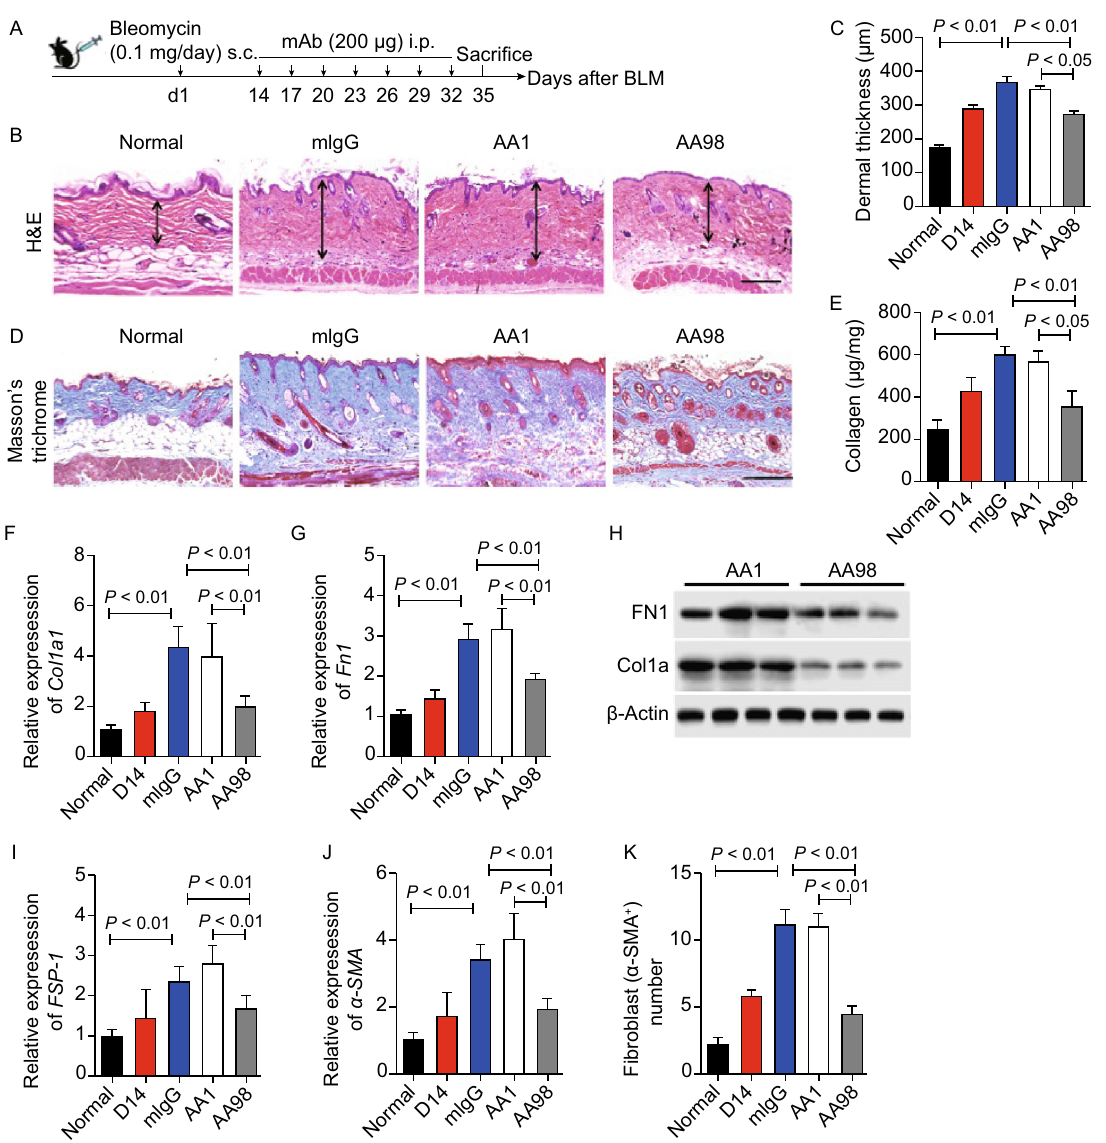
Figure 2. Therapeutic CD146-blocking with AA98 attenuates BLM-induced skin fi brosis . (A) Schematic diagram of CD146- targeting therapy using anti-CD146 AA1 or AA98 in BLM-induced skin fi brosis. (B) Mice were treated with AA1 or AA98 during BLM induction for 21 days. Lesion tissues were sectioned and stained, and dermal thickness was measured using Image J. Representative images are shown (scale bar, 100 μ m). (C) Quanti fi cation of dermal thickness in each group ( ≥ 6 sections per mouse, 10 mice per group). (D and E) Skin sections in each group were stained with Masson ’ s trichrome (D) (scale bar, 100 μ m), and collagen content (E) was measured ( n = 10 per group). (F – H) RT-PCR analysis of Col1a1 (F) and Fn1 (G) mRNA expression ( n = 10 per group) and Western blot analysis of Col1a1 and Fn1 protein expression (H) in fi brotic skin tissues ( n = 3 per group). (I and J) RT- PCR analysis of FSP-1 (I) and α -SMA (J) mRNA expression in fi brotic skin tissues ( n = 10 per group). (K) Quanti fi cation of α -SMA + fi broblasts in skin tissues ( n = 10 per group). Signi fi cant differences were determined by two-way ANOVA. Error bars indicate mean ± SEM of at least three independent